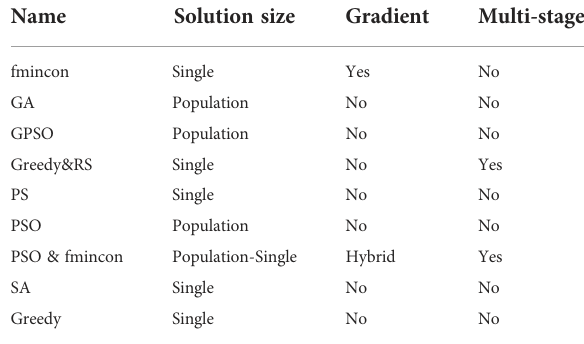
TABLE 1 Nine optimization methods implemented in the case